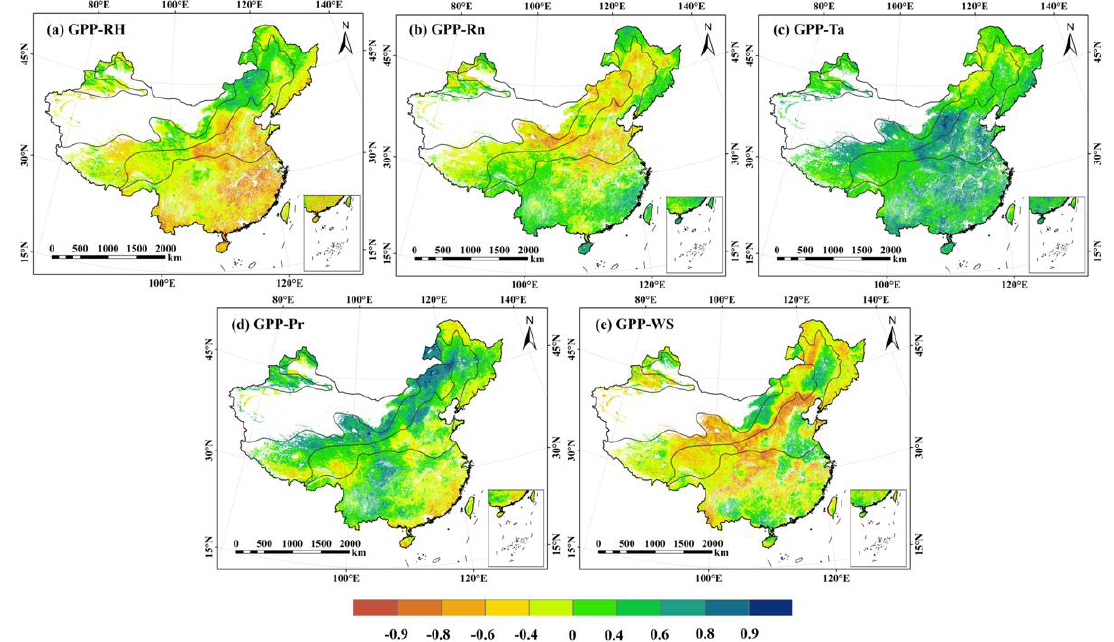
Figure 9. Spatial distribution of correlation coefficients ( − 1~1, unitless) between GPP and climatic factors from 2001 to 2021. ( a ) Relative Humidity (RH); ( b ) Net radiation (Rn); ( c ) Average temperature (Ta); ( d ) Precipitation (Pr); ( e ) Wind Speed (WS).